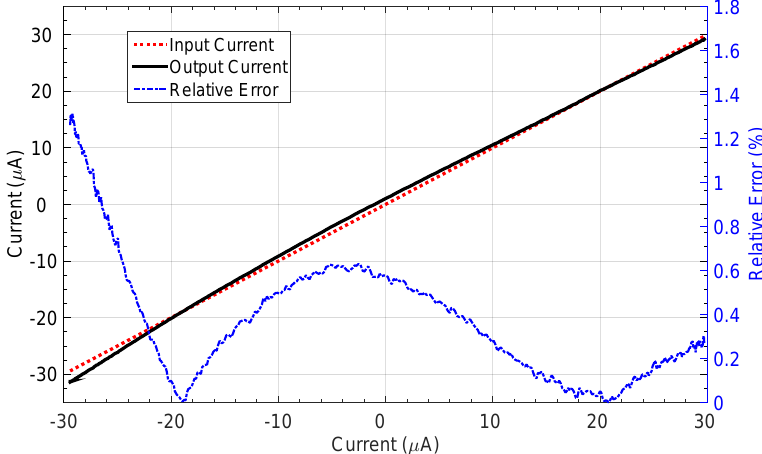
Figure 14. Integrated current buffer SB-CB2 response considering a − 30 µ A to 30 µ A input range: output current and relative error e r in the current